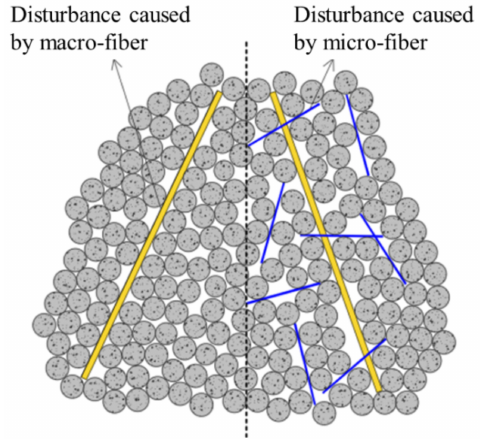
Figure 13. Disturbance effect of steel fiber on